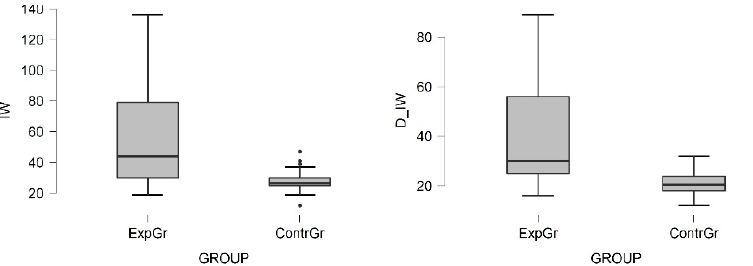
Figure 9. Boxplots showing significant differences between both groups regarding the correct language use.